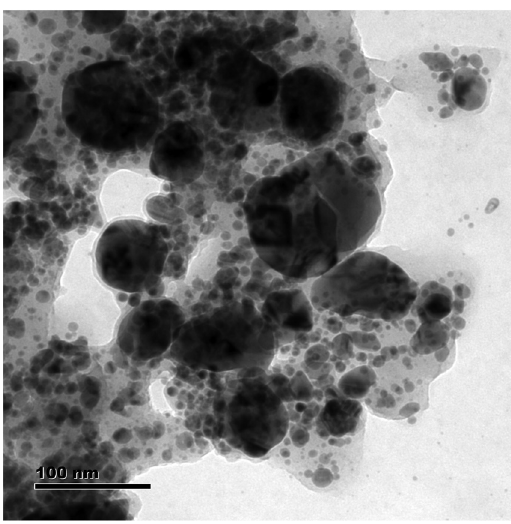
Figure 2: TEM image of synthesized Cs -